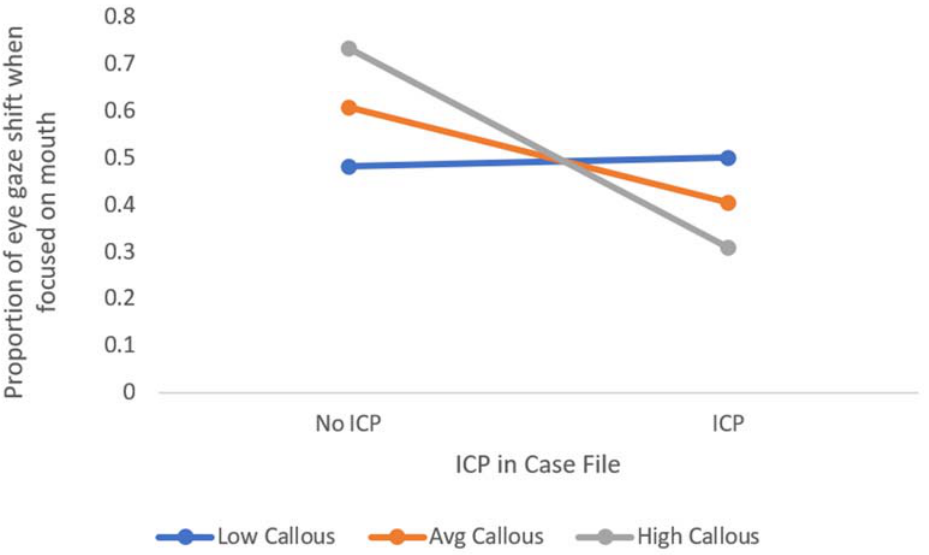
Figure 3. Post ‐ hoc illustration of interaction between the callous facet on the Inventory of Callous Unemotional Traits and ICP in explaining eye ‐ gaze shifts to the eyes for fearful faces. Unemotional Traits and ICP in explaining eye-gaze shifts to the eyes for fearful